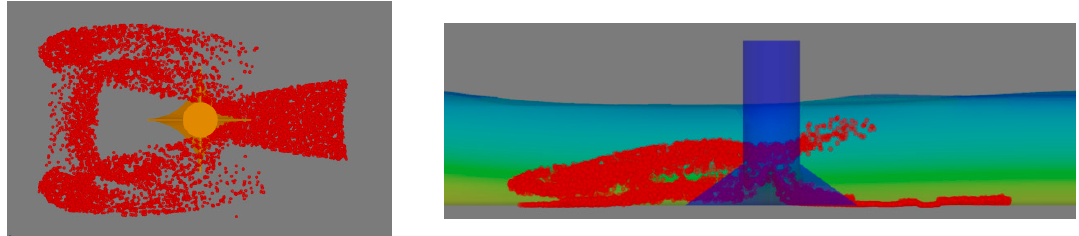
Figure 22. Plan and side view of the bed morphology after exposure to waves for 80 s (Quattro-pod mono-pile). Figure 23. Plan and side view of the bed morphology after exposure to waves for 80s (tripod monopile).